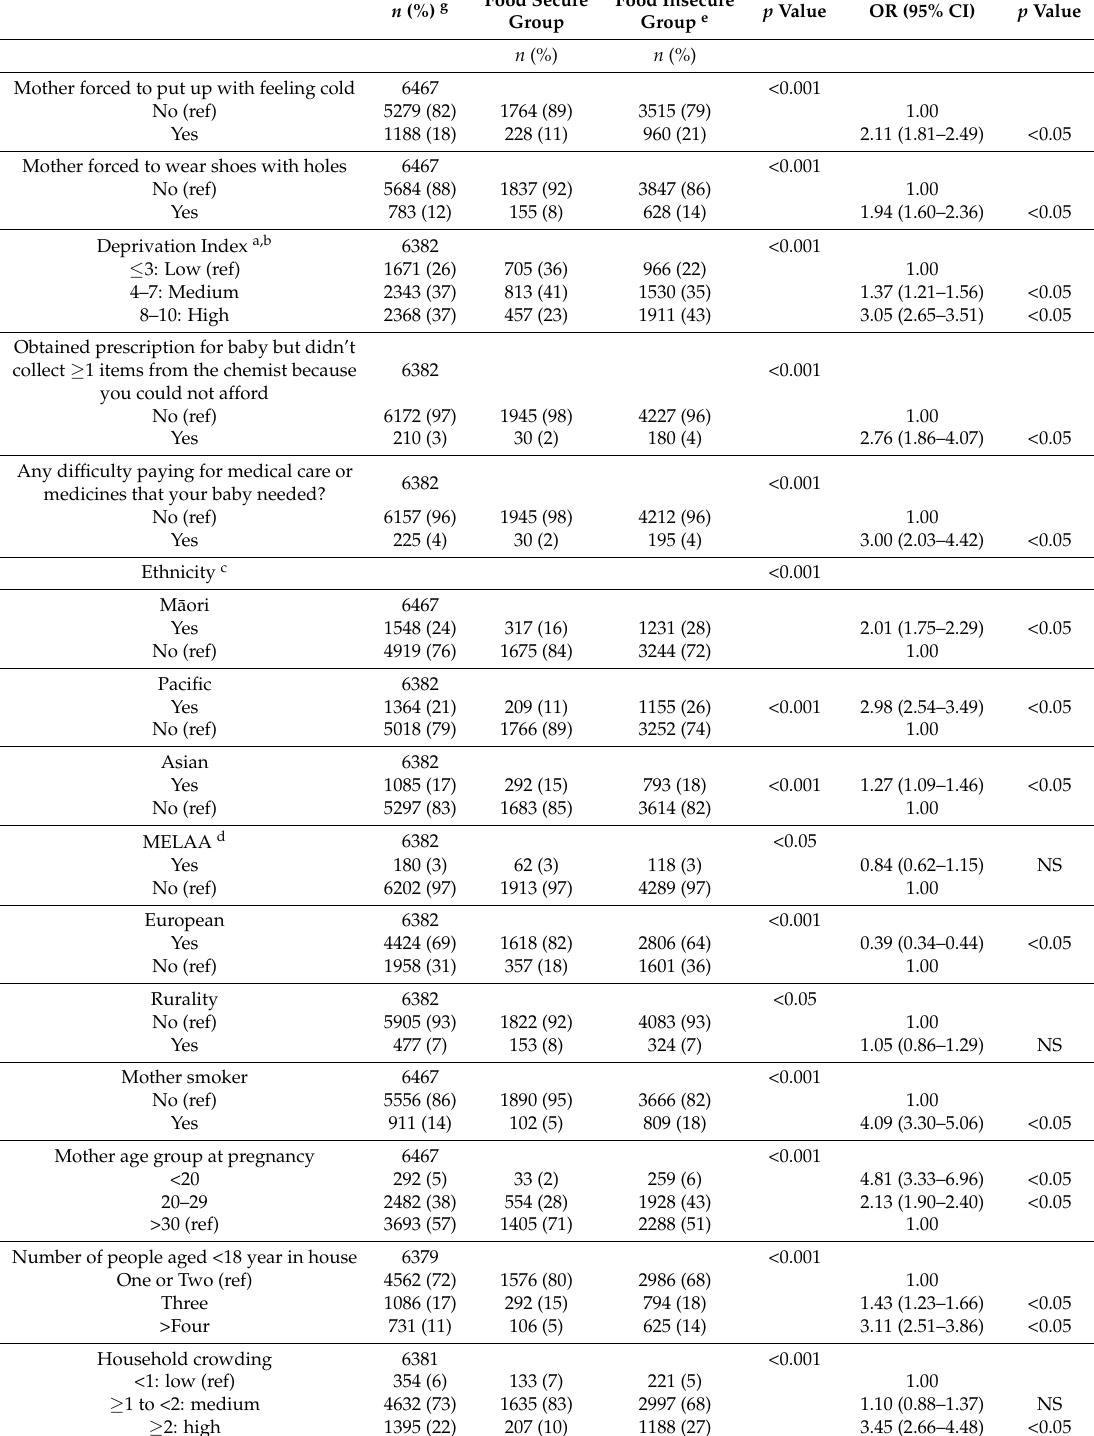
Table 6. Adjusted odds ratios (OR) for the association of demographic and socio-economic characteristics with infant food security